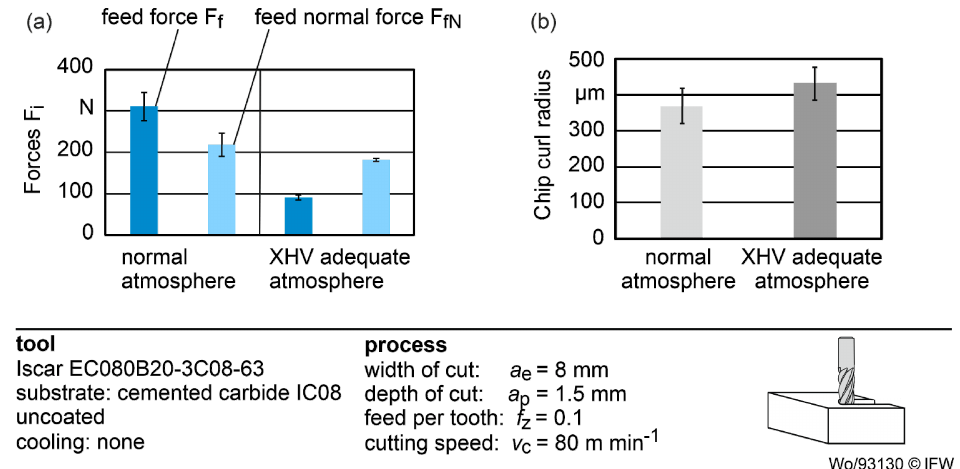
Figure 7. ( a ) Machining forces and ( b ) chip curl radius for machining in air and machining under an XHV-adequate atmosphere.